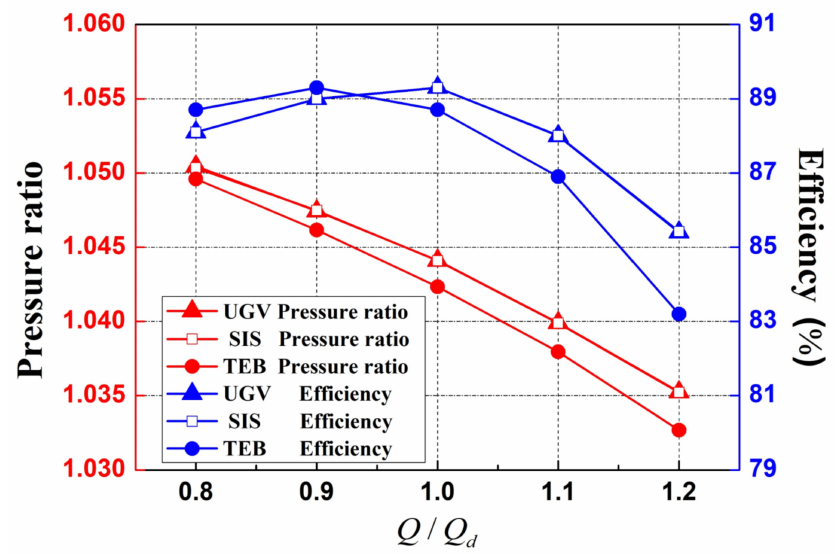
Figure 5. Compressor characteristic performance comparison of the UGV, SIS, and TEB models.